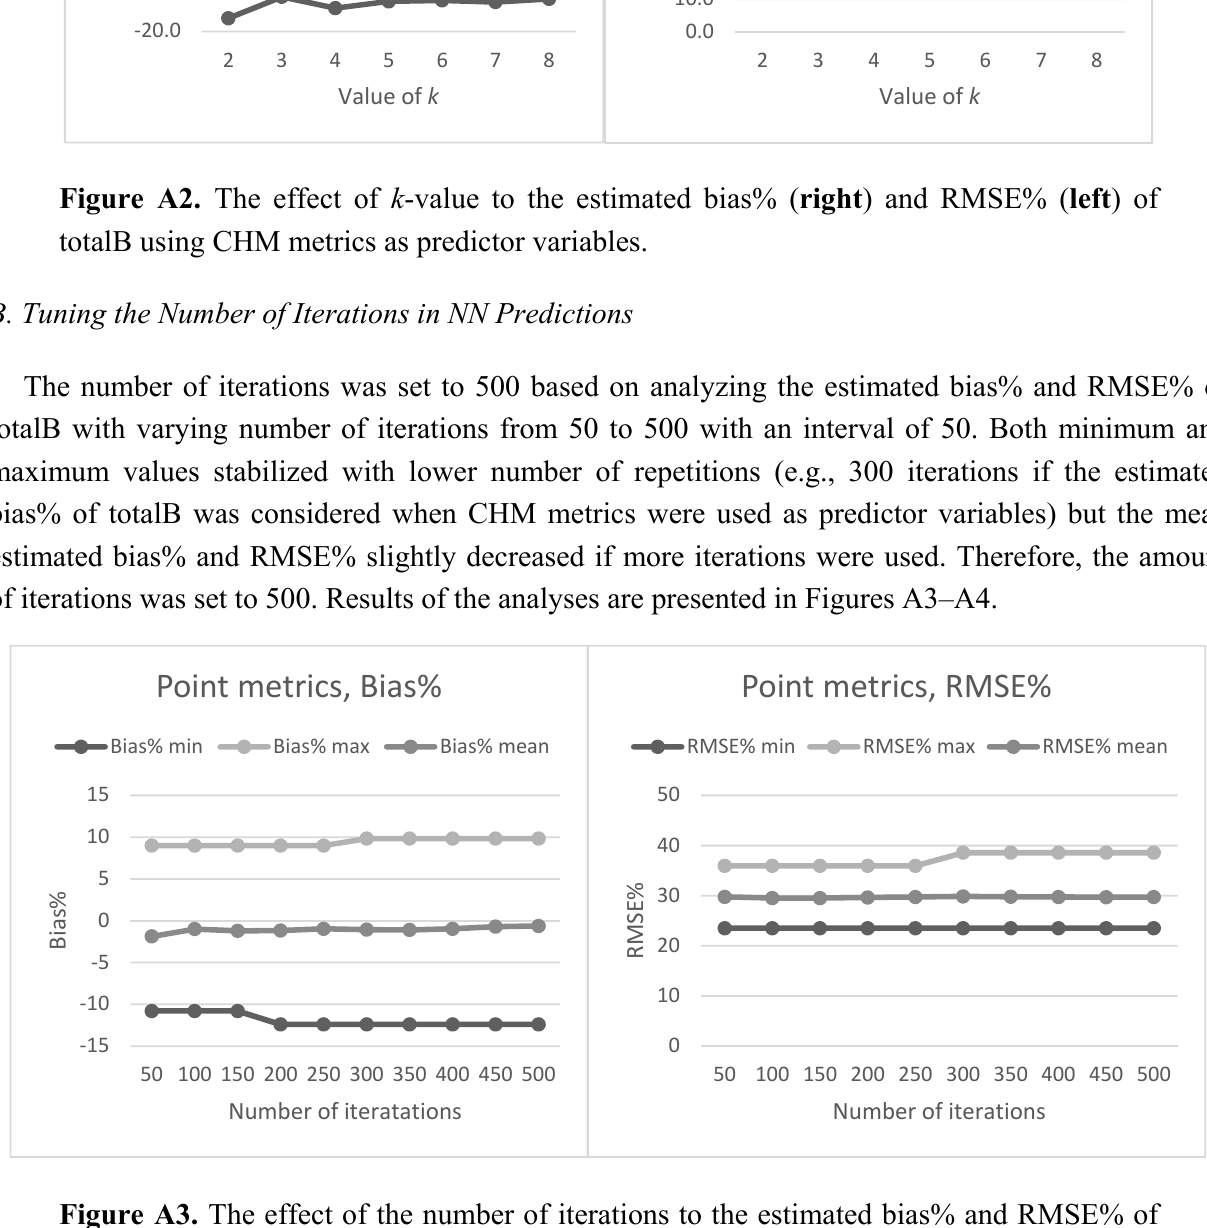
Figure A3. The effect of the number of iterations to the estimated bias% and RMSE% of totalB when point metrics were used as predictor variables. The effect was analyzed by varying number of iterations from 50 to 500 with an interval of